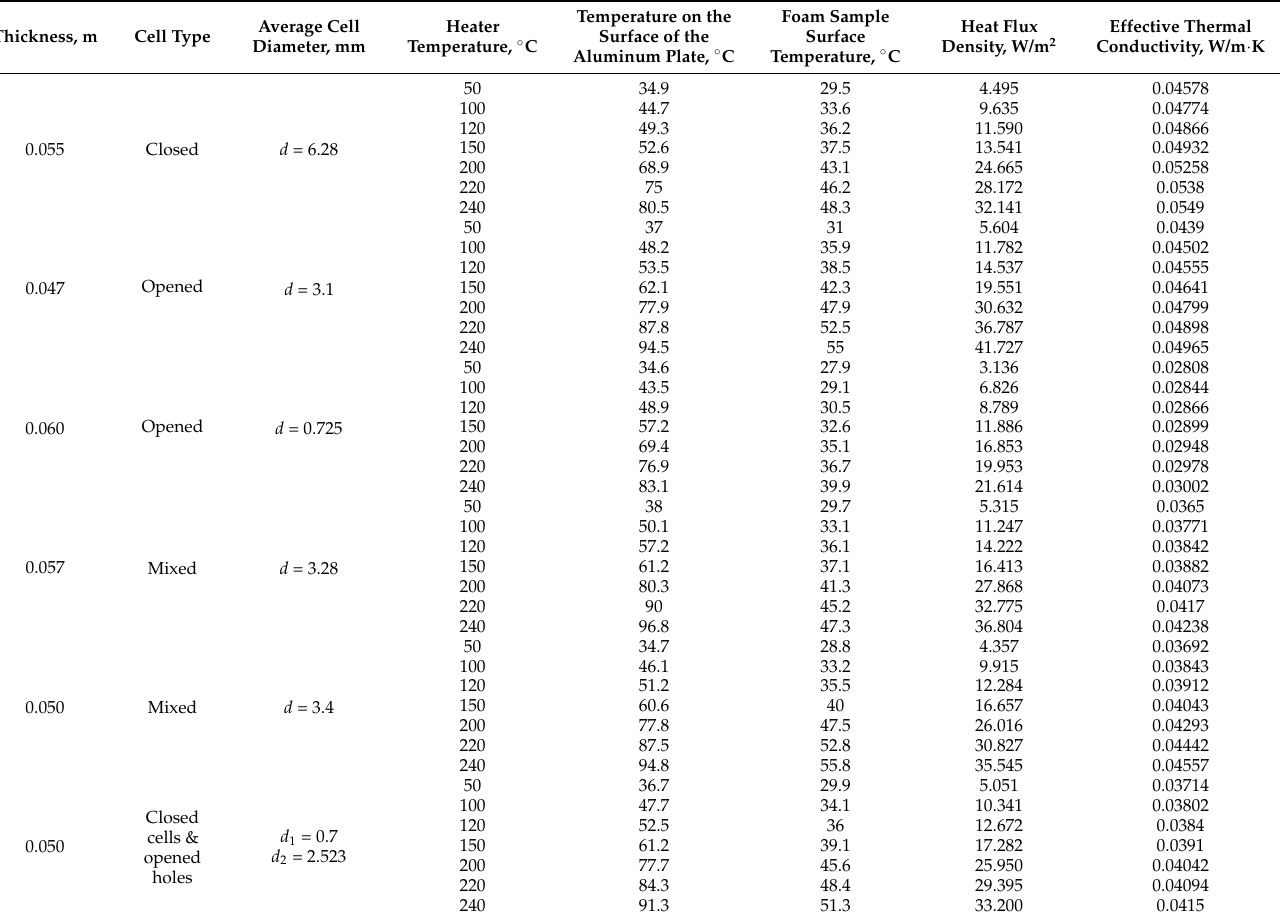
Table 2. The results of measuring the effective thermal conductivity of polyurethane foams in the case when the heater is placed